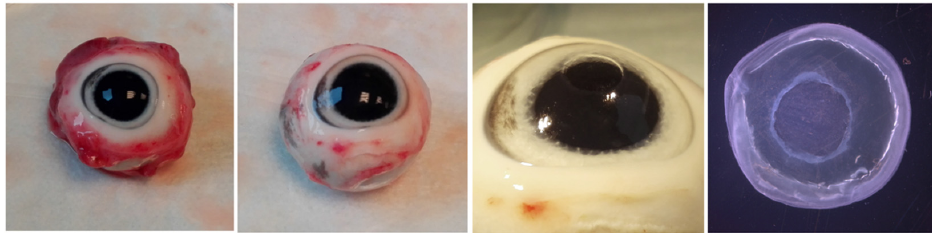
Figure 1. Preparation of pig eyes, wounding and corneal tissue isolation for organ culture photo documentation of the corneal preparation to start cornea organ culture. After removal of muscle and connective tissue the wound was prepared using a small biopsy punch (here 4 mm diameter) and a hockey knife. The resulting epithelial defect was visible with optimized illumination. The whole corneal tissue is excised from the eye with a 10 mm biopsy punch and was cultivated free floating in a microplate well.